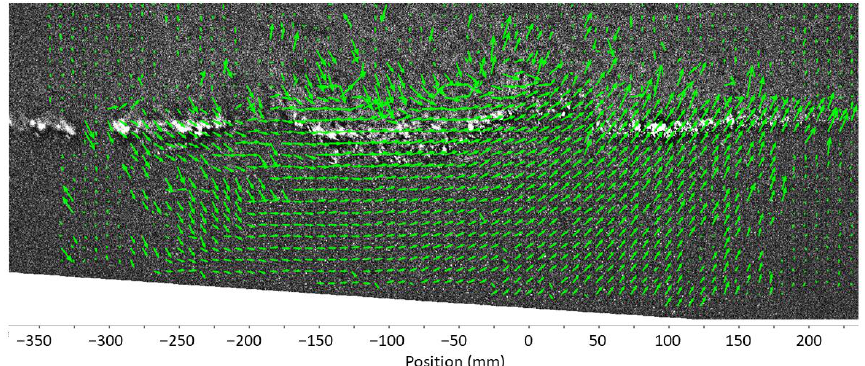
Figure 8. Sample PIV velocity field (raw image, no quality control), measuring approximately 60 cm width and 20 cm height. Orbital velocity fields (green arrows) are generated by waves propagating from right to left. The underside of the surface ice is visible as a fuzzy white line near the vertical center of the image. Data are from trial 18.